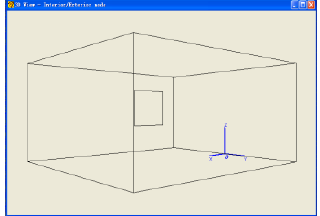
Figure 3. Sound field model by use of ODEON 8.0 in Room A.